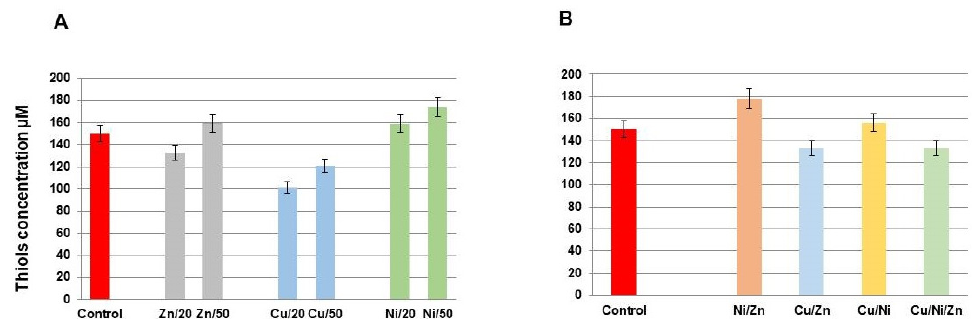
Figure 6. Total thiol content in the cell lysate of S. xiamenensis DCB2-1 under zinc, copper, and nickel single ( A ) and combination action ( B ). Metal concentrations in single systems are 20 and 50 mg/L; metal concentrations in complex systems are 20 mg/L. The data presented are the mean values ± SD from three separate sets of